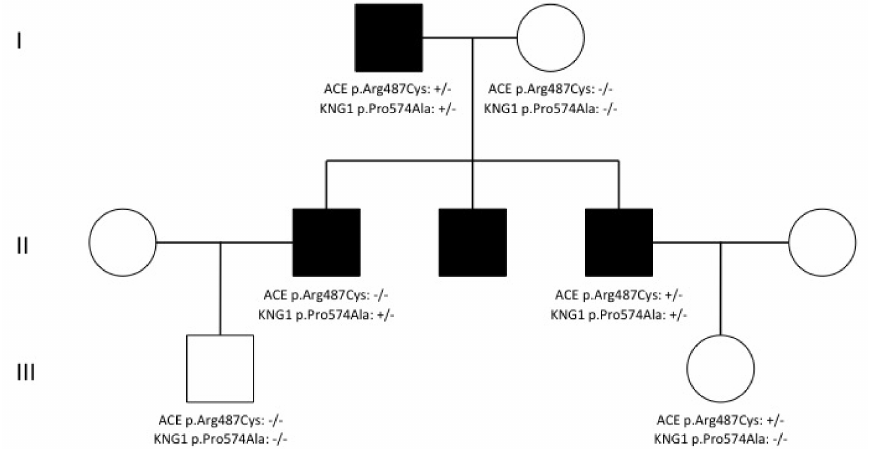
Figure 1. Pedigree demonstrating co-segregation of the missense mutation of the KNG1 p.Pro574Ala (c.1720C > G) and the ACE p.Arg487Cys (c.1459C > T) variants with